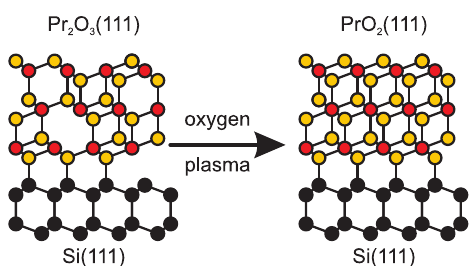
Figure 5. Schematic drawing of the plasma oxidation process. Randomly distributed oxygen vacancies in the Pr O film are occupied by oxygen from the oxygen plasma. The drawing 2 3 considers also the B orientation of the praseodymia films with respect to the Si(111)